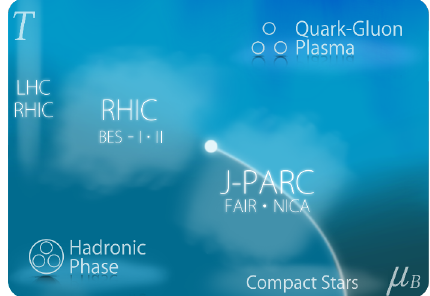
Figure 1. Schematic view of the QCD phase diagram